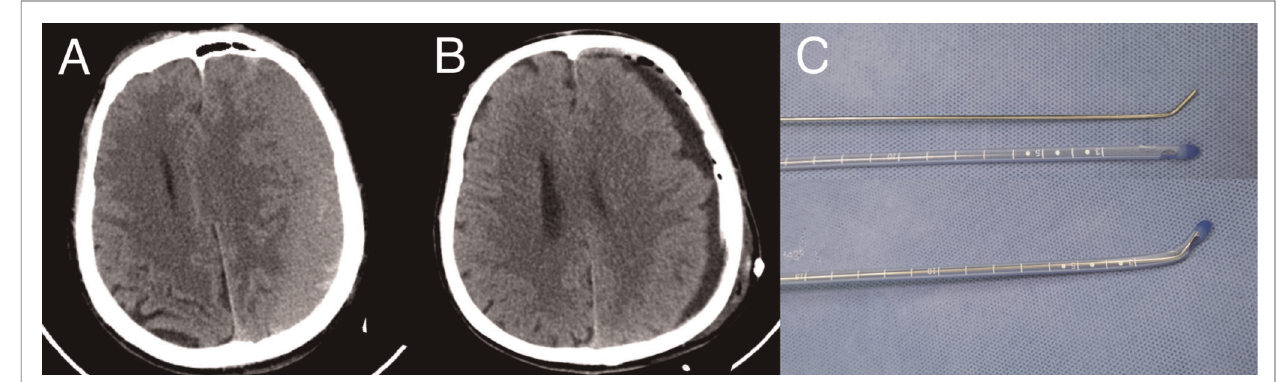
FIGURE 2 | Case illustration. ( A ) The initial CT scan on presentation reveals the left chronic subdural hematoma. ( B ) CT of the head following the placement of drainage demonstrates the almost complete resolution of the left chronic subdural hematoma. ( C ) The guidewire and catheter used in the technique; the guidewire was bent at an angle of